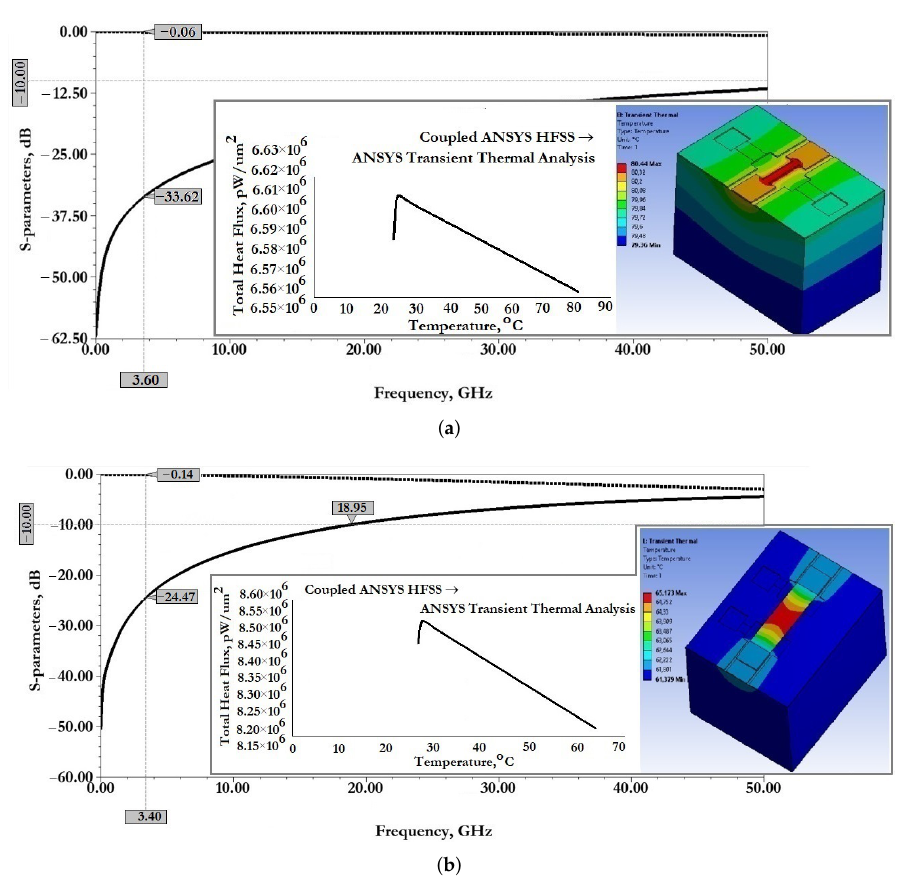
Figure 11. The results of EM and transient thermal modeling: ( a ) CPW (A); ( b ) CPW